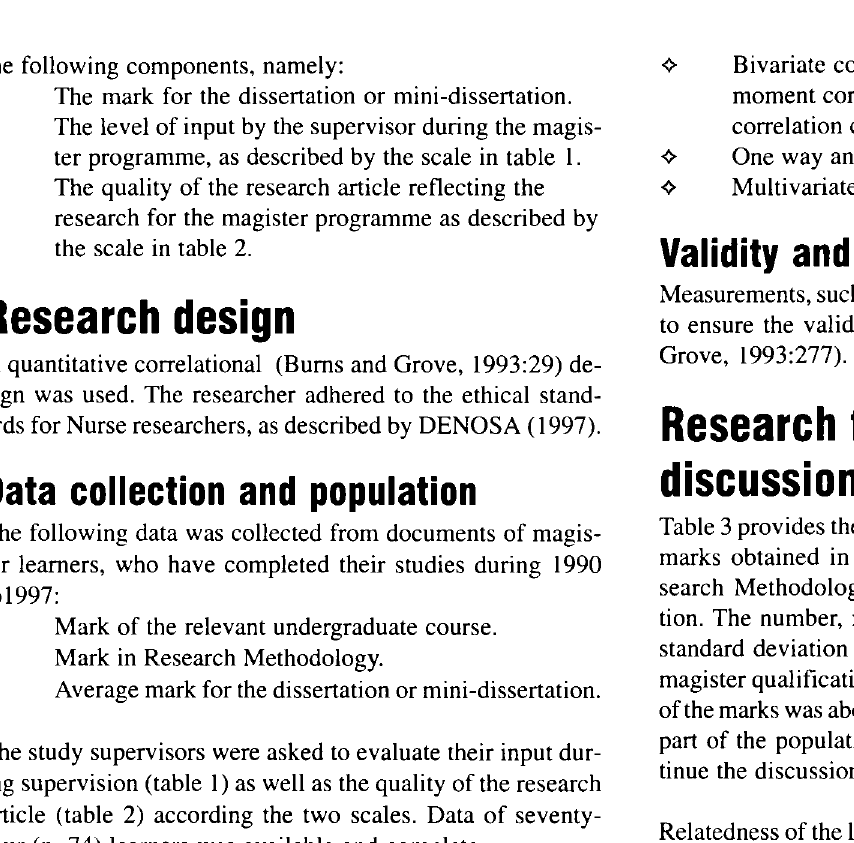
Table 1 Scale for the evaluation of input during study